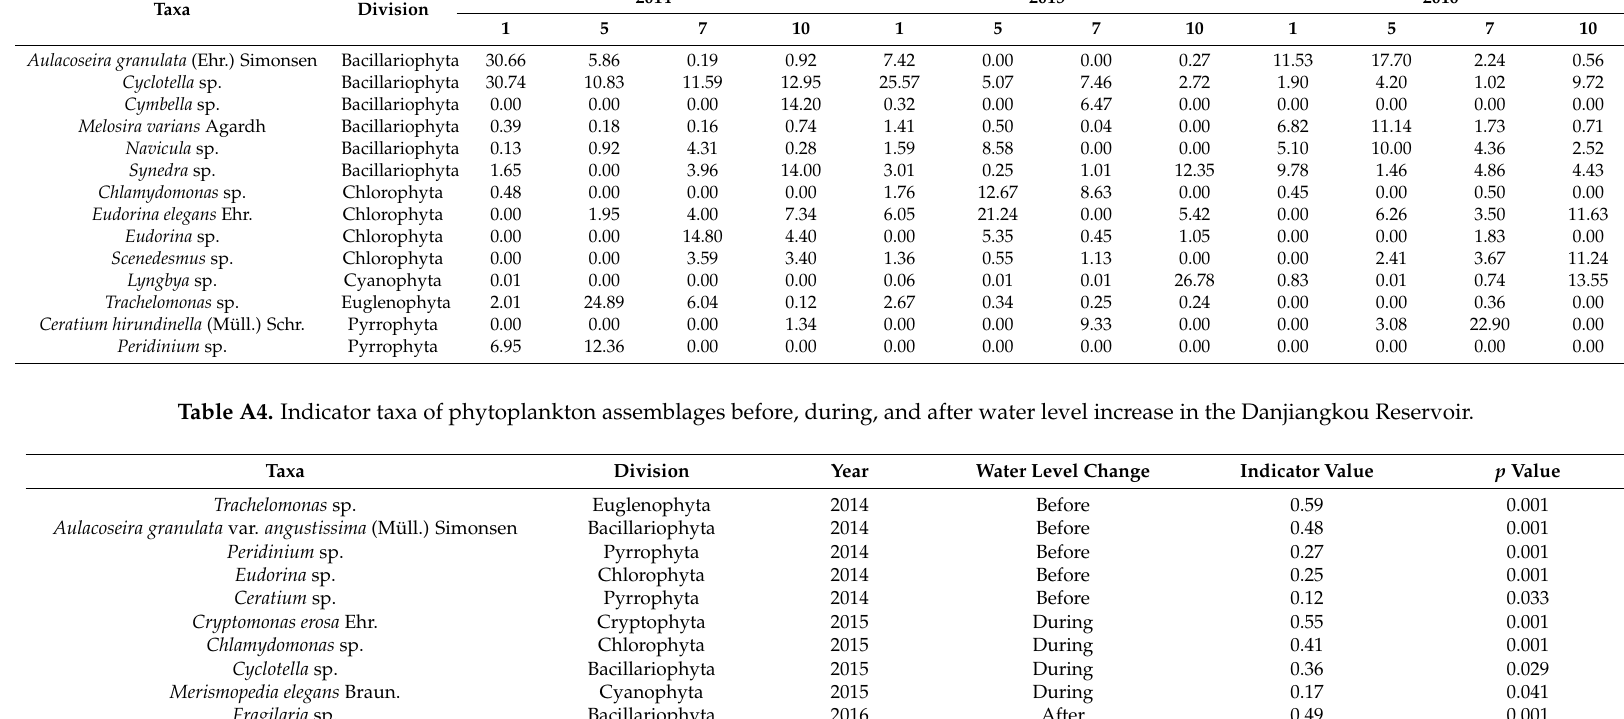
Table A3. Seasonal and year-to-year variation of mean relative abundance of the dominant taxa (% of total biomass) in the Danjiangkou Reservoir between 2014 and 2016.